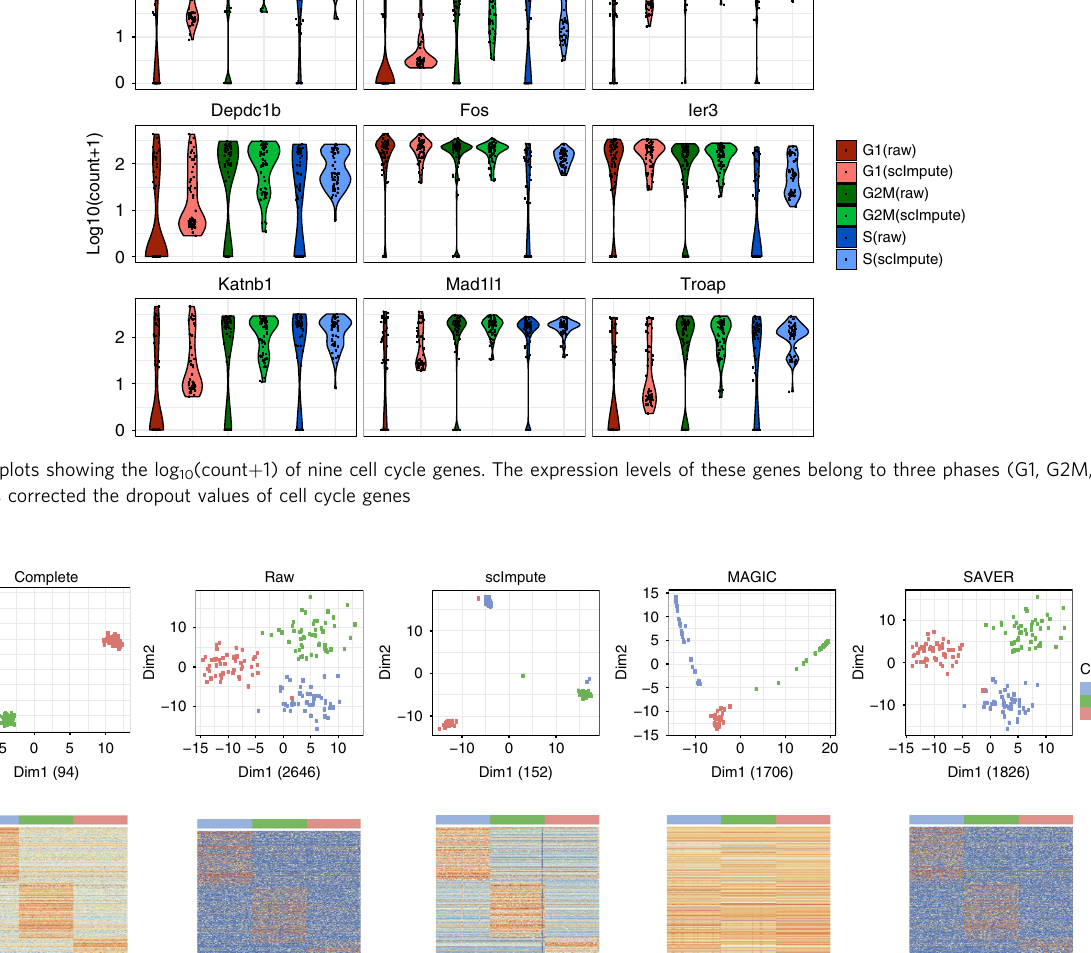
(cid:2) (cid:2) P P P (cid:2) (cid:2) 3 50 50 (cid:2) y ¼ 1 y kj is a vector of length 2, denoting (cid:2) (cid:2) 2 , where y k (cid:3) k (cid:3) k ¼ 1 j ¼ 1 y kj j ¼ 1 y kj and 50